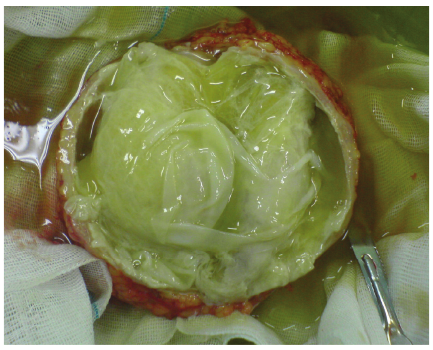
Figure 2: Macroscopic figure of